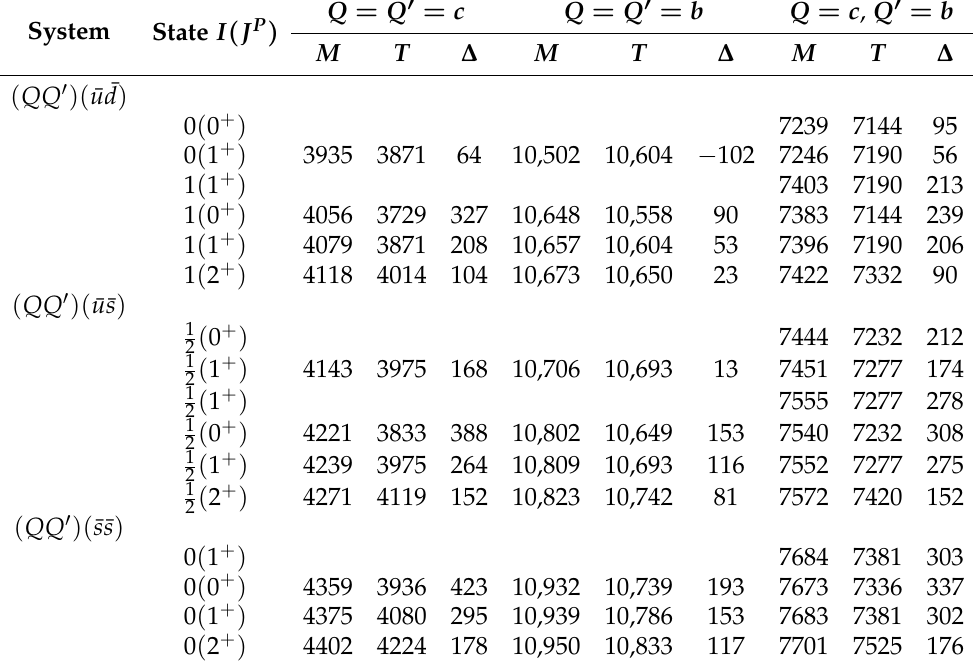
Table 7. Masses M of heavy-diquark ( QQ (cid:48) )–light-antidiquark (¯ q ¯ q ) states. T is the lowest threshold for decays into two heavy–light ( Q ¯ q ) mesons and ∆ = M − T . All values are given in